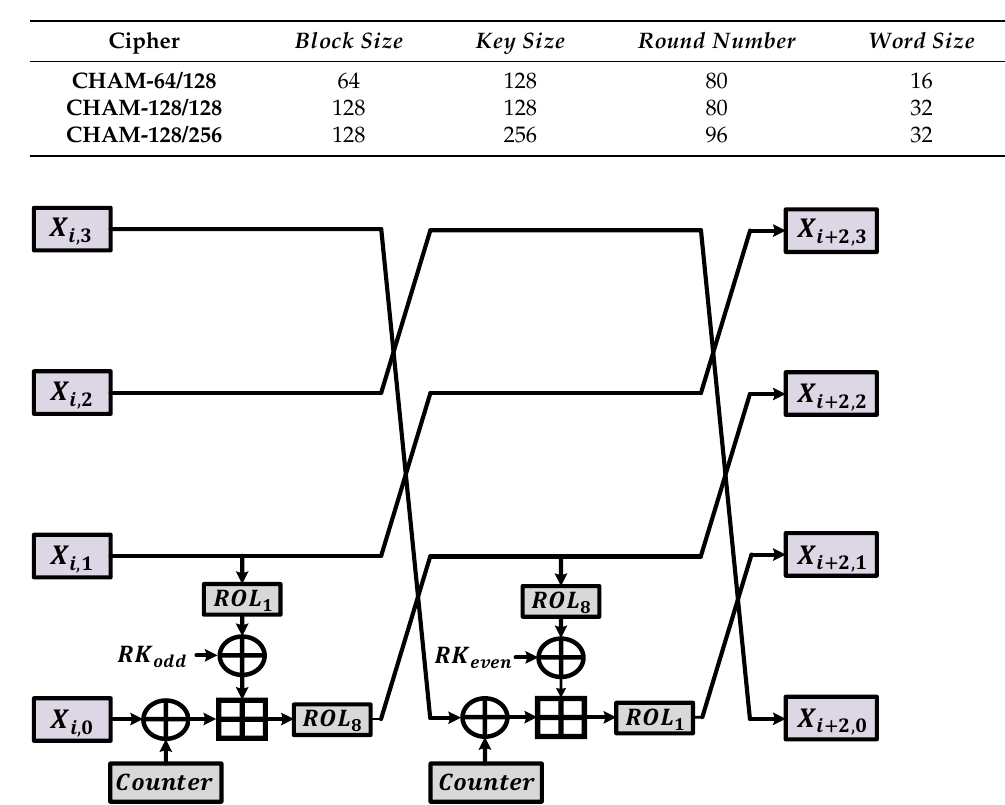
Table 3. Parameters of CHAM [16].